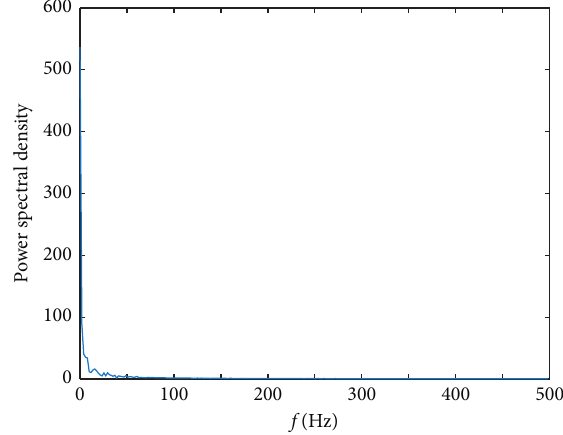
Figure 5: Power spectral density analysis.